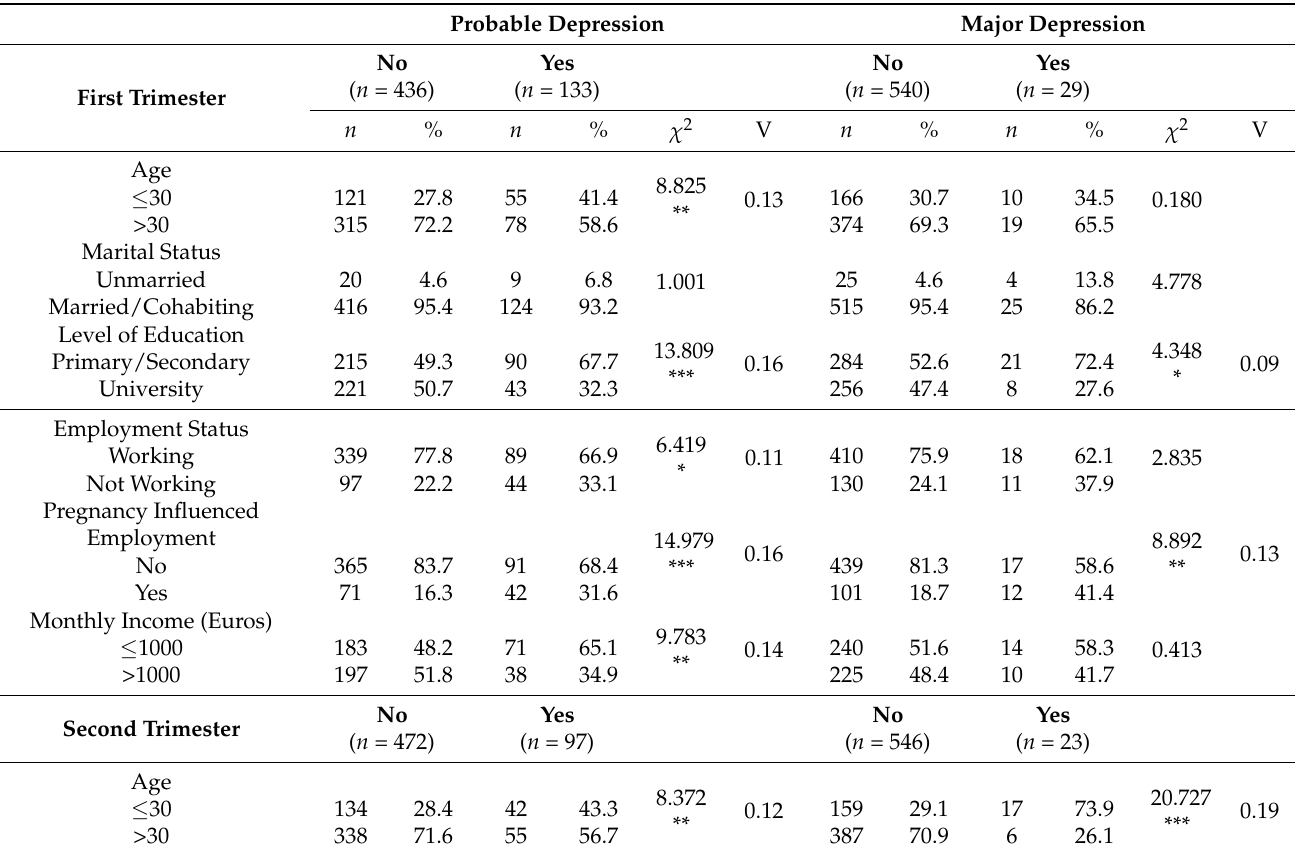
Table 1. Characteristics of women with probable depression and major depression as a function of sociodemographic